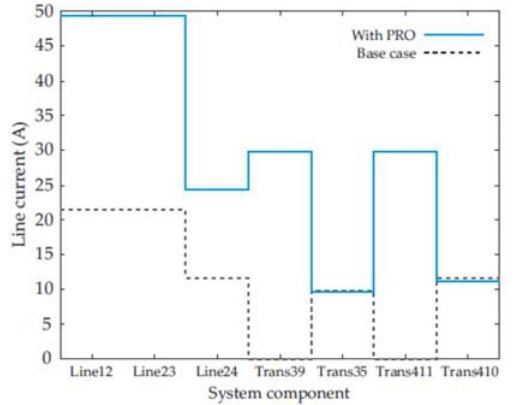
Figure 14. Line currents for different system components.